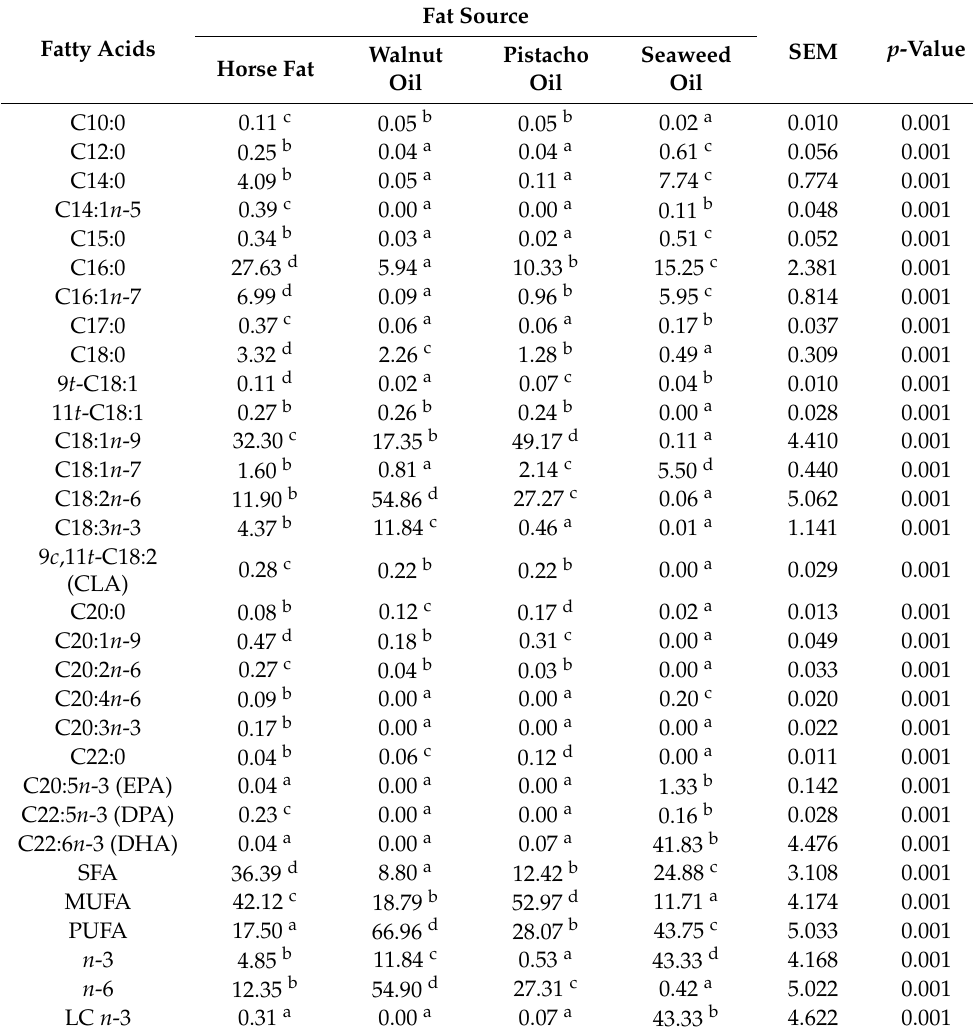
Table 2. Fatty acid composition (expressed as g/100 g of fat) of foal subcutaneous fat and oils employed for p â t é